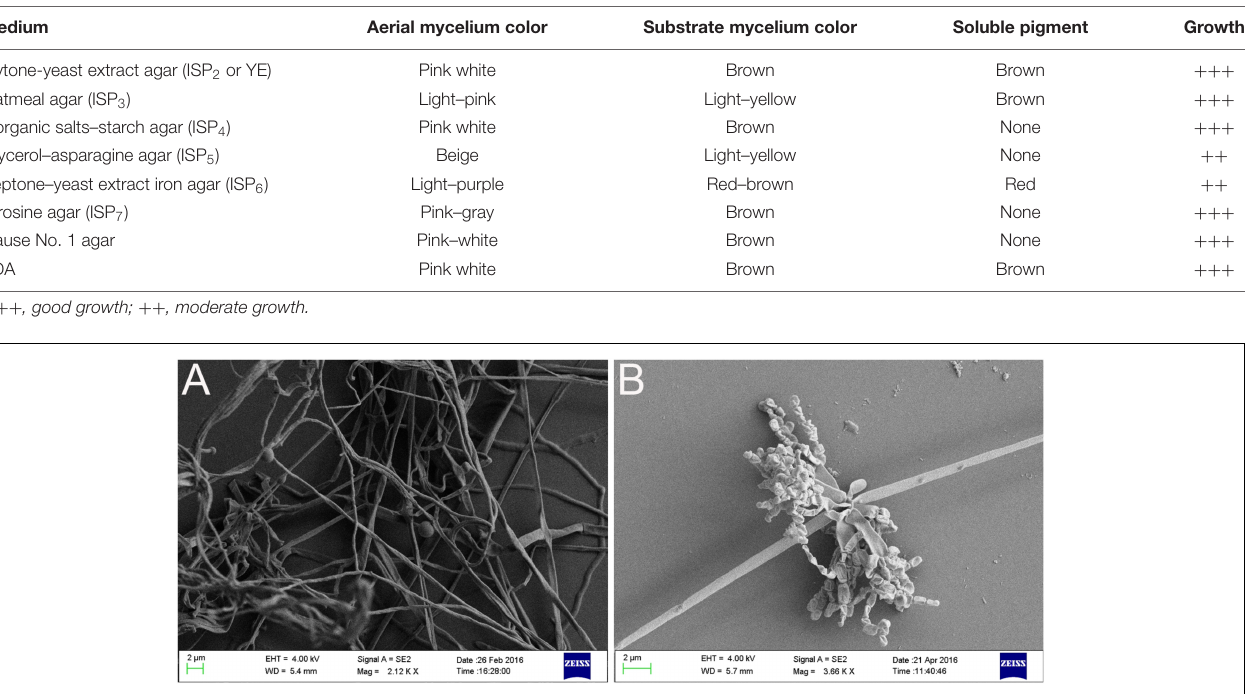
FIGURE 2 | Morphologic characteristics of mycelium (A) as well as spore chain and spore (B) of strain